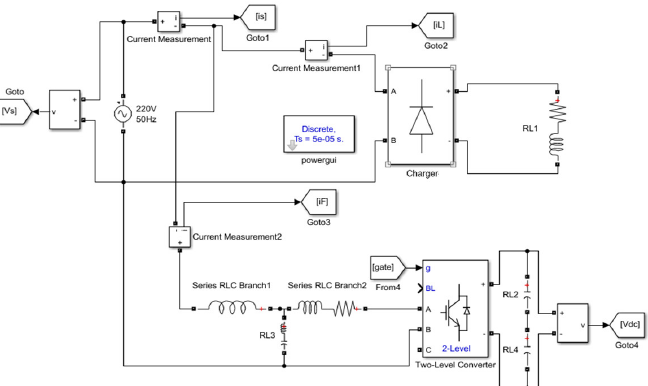
Figure 8. Experimental diagram of Butterworth filter.